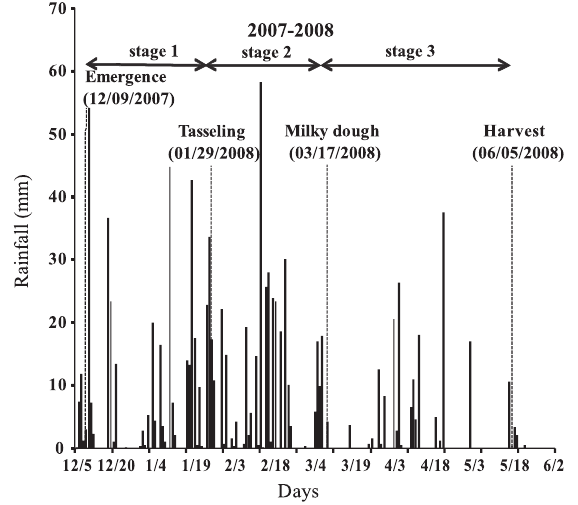
Figure 2. Rainfall in the growth stage of the 2007- 2008 growing season. Stage 1: From emergence until tasseling; stage 2: From tasseling until milky /dough; stage 3: until